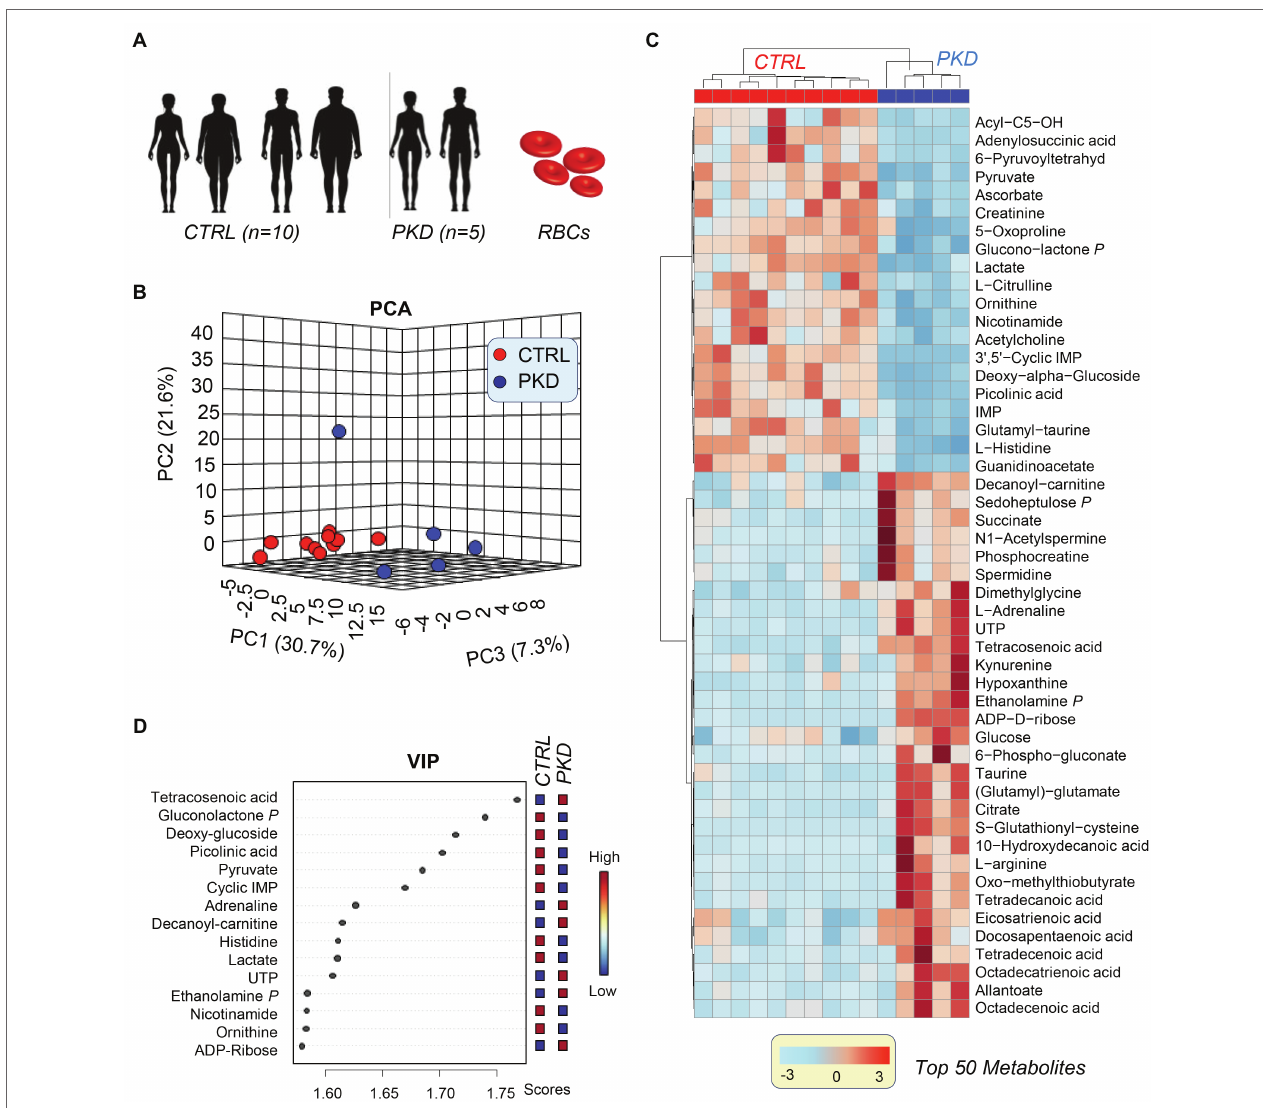
FIGURE 1 | Multivariate analysis reveals a unique metabolic profile of pyruvate kinase deficiency (PKD) patients when compared with unaffected controls. (A) Samples from five PKD patients and 10 unaffected controls were analyzed with untargeted metabolomics procedures using ultra-high-pressure liquid chromatography-mass spectrometry (UHPLC-MS). (B) A principal component analysis (PCA) clustered samples by metabolic phenotype and revealed that PKD samples were metabolically divergent from control samples. (C) The variable importance in projection (VIP) values from a partial least square discriminant analysis (PLS-DA) display the metabolites that contributed most to the clustering pattern. (D) A hierarchal clustering analysis (HCA) of the top 50 significant metabolites by ANOVA shows differences between PKD and CTL samples, especially in amino acid, glucose, and fatty acid